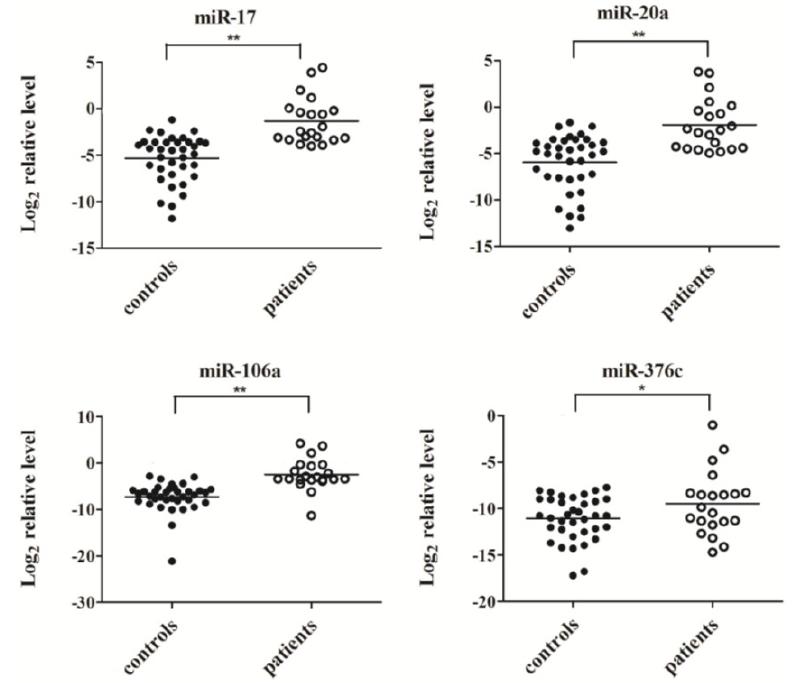
relative level). 2